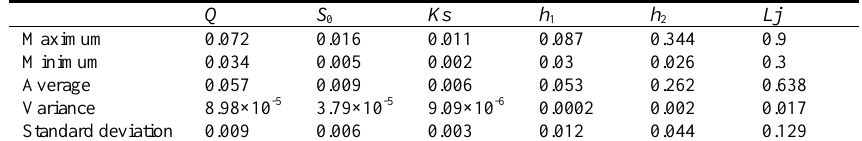
Table 2. The minimum, maximum, variance, and standard deviation of the experimental parameters measured by Kumar et al .